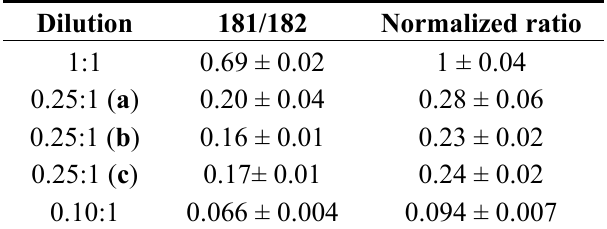
Table 1. Relative quantitation of the bovine serum albumin (BSA) nitropeptide, Y*LYEIAR ( m / z 487.2), identified from the microglial cell lysate digest background matrix. Ratio values are presented as the mean ± SD (indicating scan-to-scan variability). Individual technical replicates ( n = 3) of the 0.25:1 ratio samples are shown as ( a ), ( b ) and ( c ).